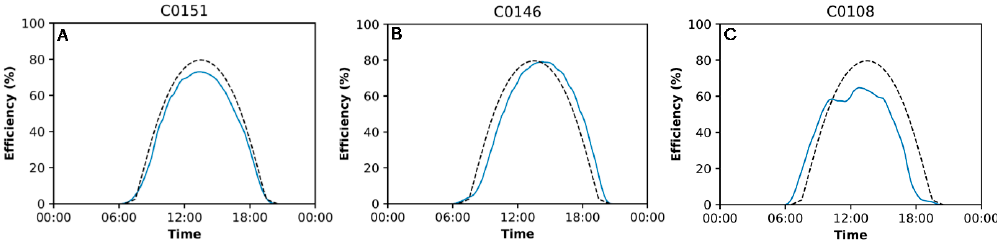
Figure 7. Weekly mean efficiency curves of three photovoltaic (PV) systems with contrasting orientation index. ( A ) PV system with an orientation index of I = 0 h; ( B ) PV system with negative orientation index ( I = –0.625 h); and ( C ) PV system with positive orientation index ( I = 1.125 h). Blue curves indicate the observed weekly mean efficiency, and black dashed curves indicate the simulated efficiency under optimum conditions.